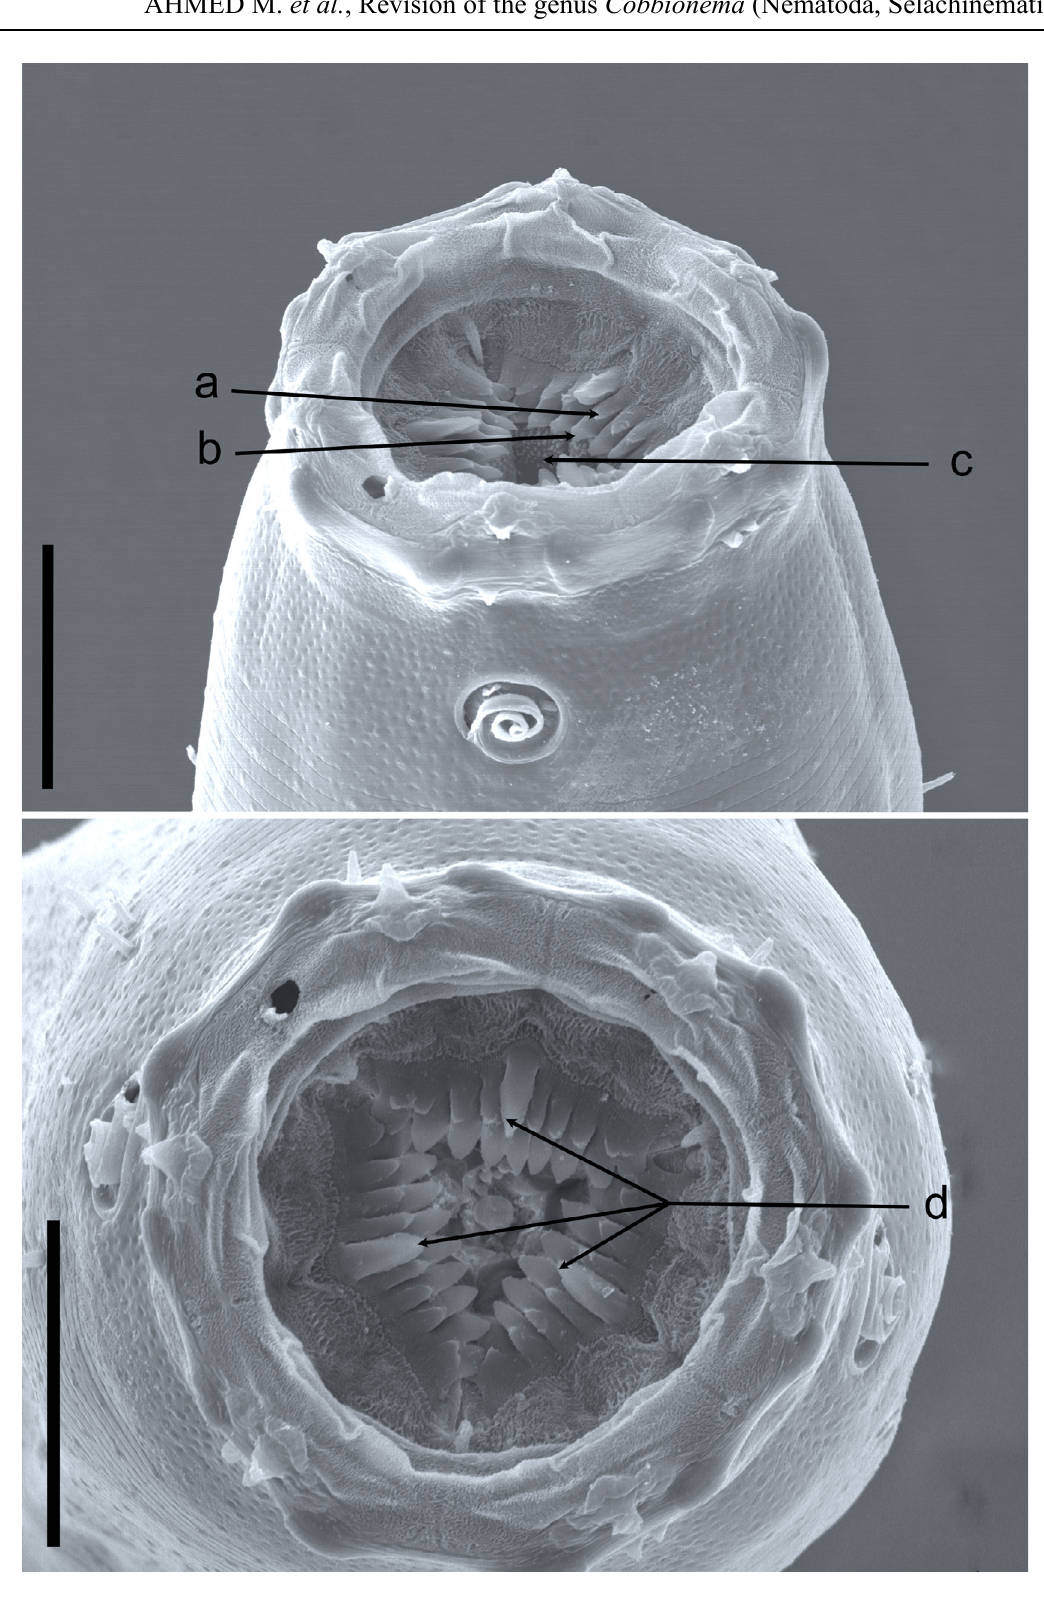
Fig. 1. Halichoanolaimus robustus (Bastian, 1865). Scanning electron micrographs. Abbreviations: a = anterior row of pointed projections; b = posterior row of pointed projections; c = field of distinct denticles; d = the three tines (one middorsal, two ventrosublateral). Scale bar = 25